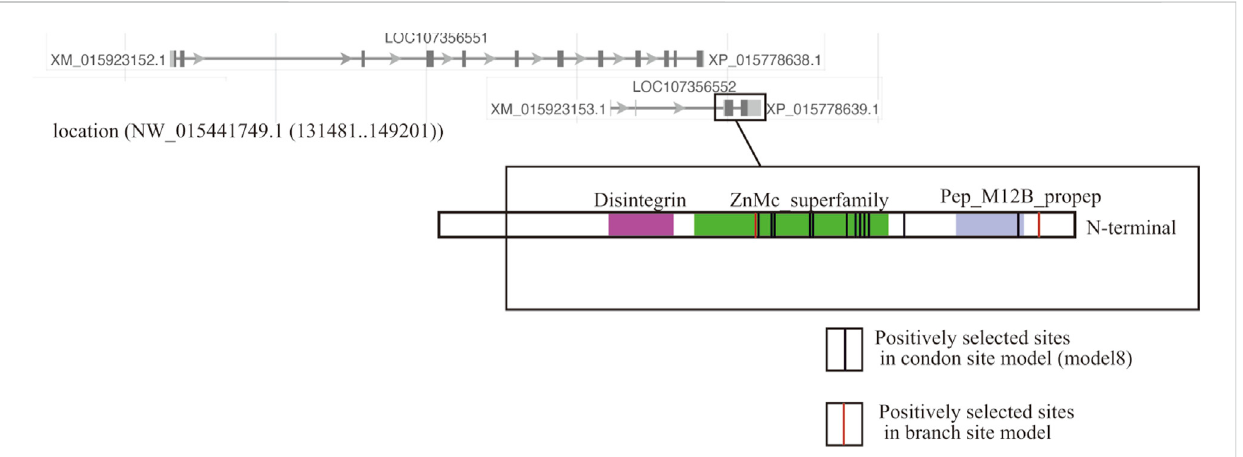
FIGURE 1 Localization of two copies of ADAM10 on the genome of the coral Acropora digitifera. Of the two ADAM10 sequences (XP_015778638.1, XP_ 015778639.1),thesubstitutionratesoftheseverallimitedaminoacidsitesinonecopy(XP_015778639.1)wasaccelerated.Theredlinesshowcodonsites in the Bayes empirical Bayes (BEB) analyses in the branch site model, and the black lines indicate the codon site model (Table